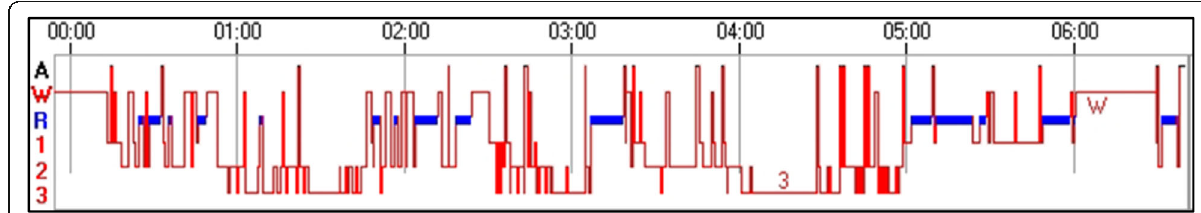
Fig. 1 Hypnogram of a diabetic patient with peripheral neuropathy showing sleep fragmentation and increase in each of waking after sleep onset, arousal index, and sleep stage transition